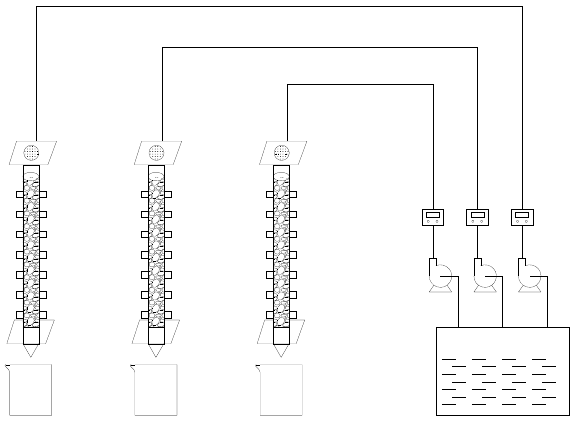
Figure 1. Schematic diagram of a simulated dynamic leaching experiment device.